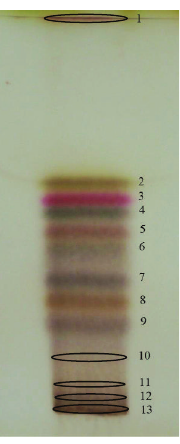
Table 1: The program used for four-step gradient elution for the development in second dimension for Juniperi Oleum . Mobile phase